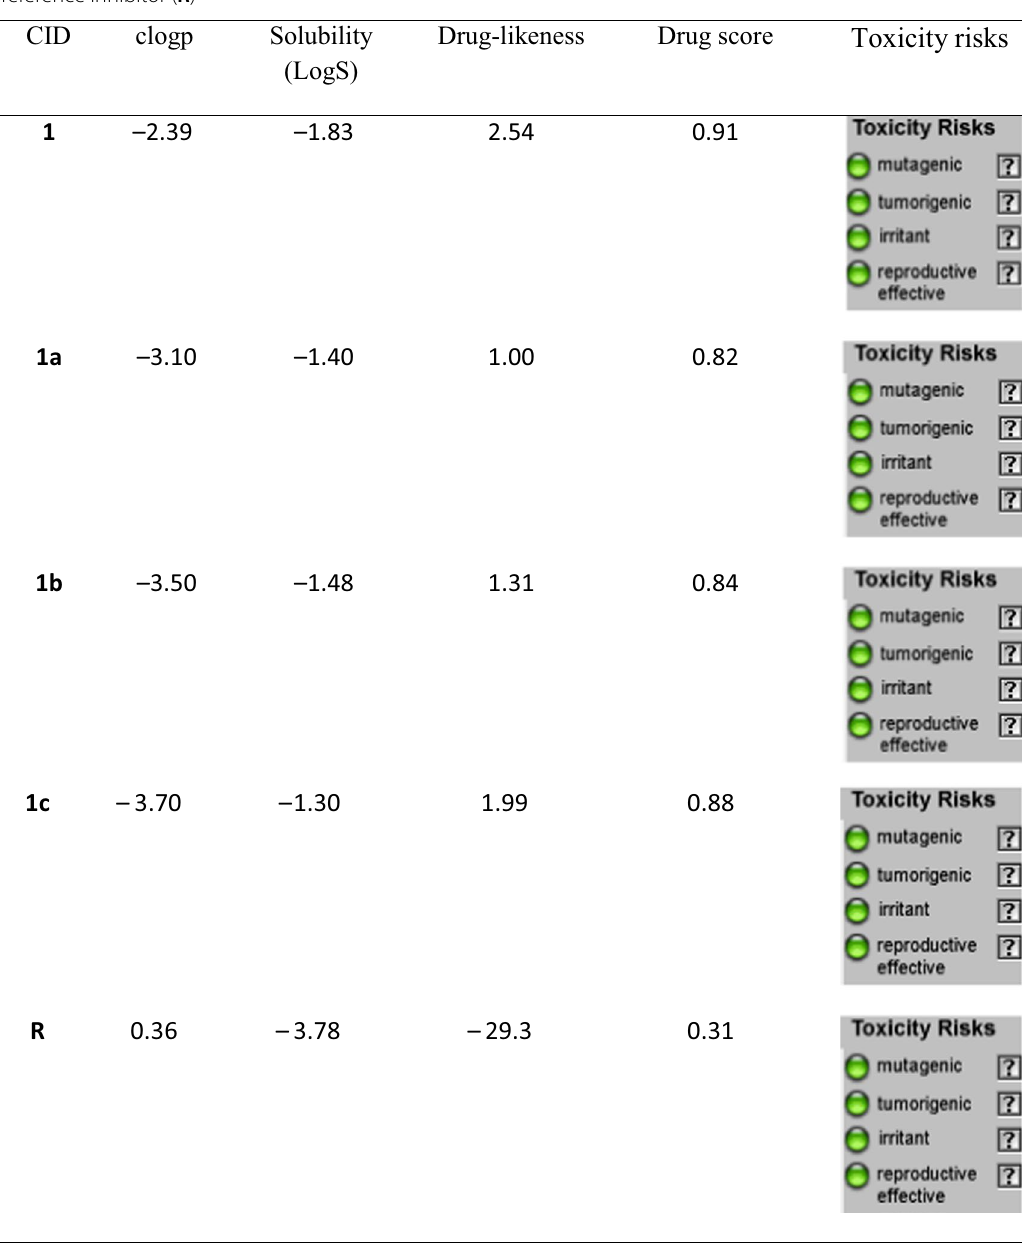
Table 4 The pharmacological characteristics drug scores and toxicity risks for molecule 1 , designed molecules ( 1a – 1c ), and Sofosbuvir as reference inhibitor ( R